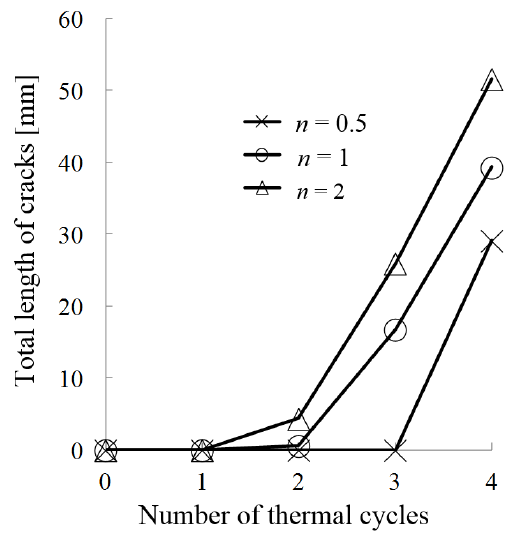
Figure 10. Cyclic thermal shock fracture behavior of FG TBCs. Relation between total length of cracks on ZrO 2 surface and number of thermal cycles is